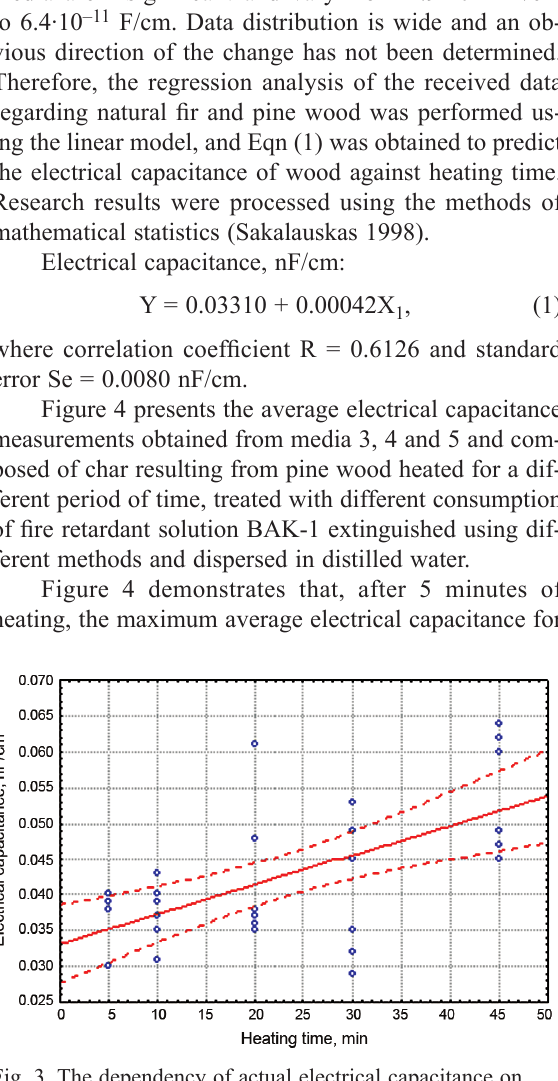
fig. 3. the dependency of actual electrical capacitance on heating time for media 1 and 2